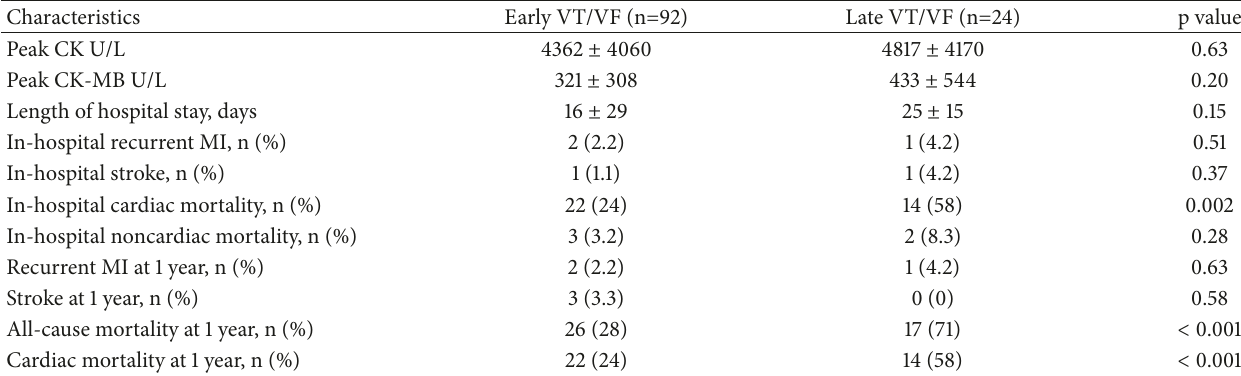
Table 3: Clinical outcomes of the patients with early VT/VF or late VT/VF.